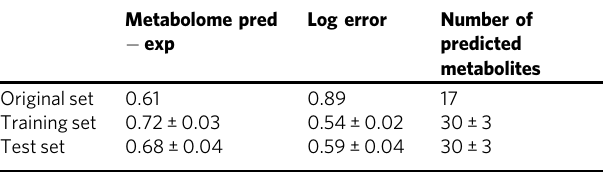
Table showing the performance of the ecological cross-feeding model with the original set of interactions (consumption and production links), and with the additional interactions predicted by GutCP (both the training and test set performances; see main text). Performance is measured using three metrics: (1) the correlation between the predicted and experimentally measured metabolome, (2) the log error (see main text), and (3) the number of metabolites in the measured metabolome predicted by our ecological consumer-resource model. Values